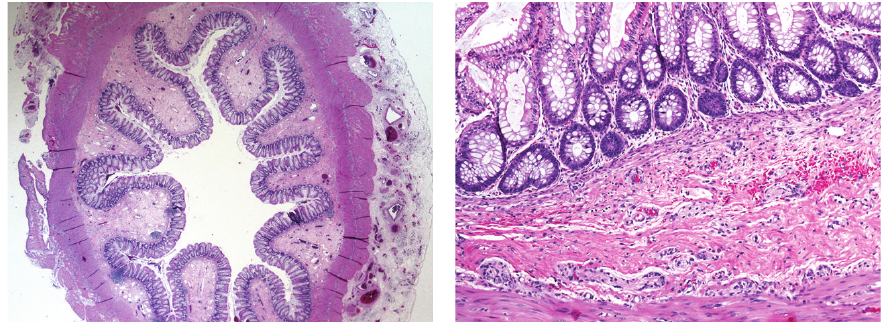
Figure 3: Histology of the CSD of the colon revealed normal architecture of the